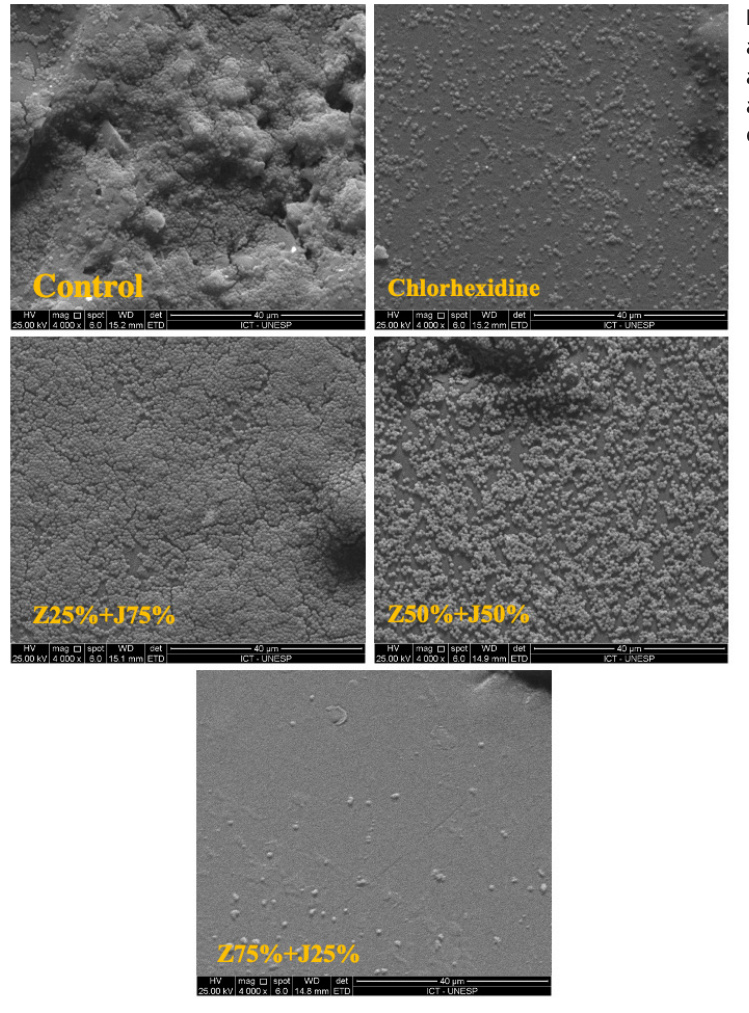
Figure 3. Antibiofilm activity of the association of extracts analyzed by scanning electron